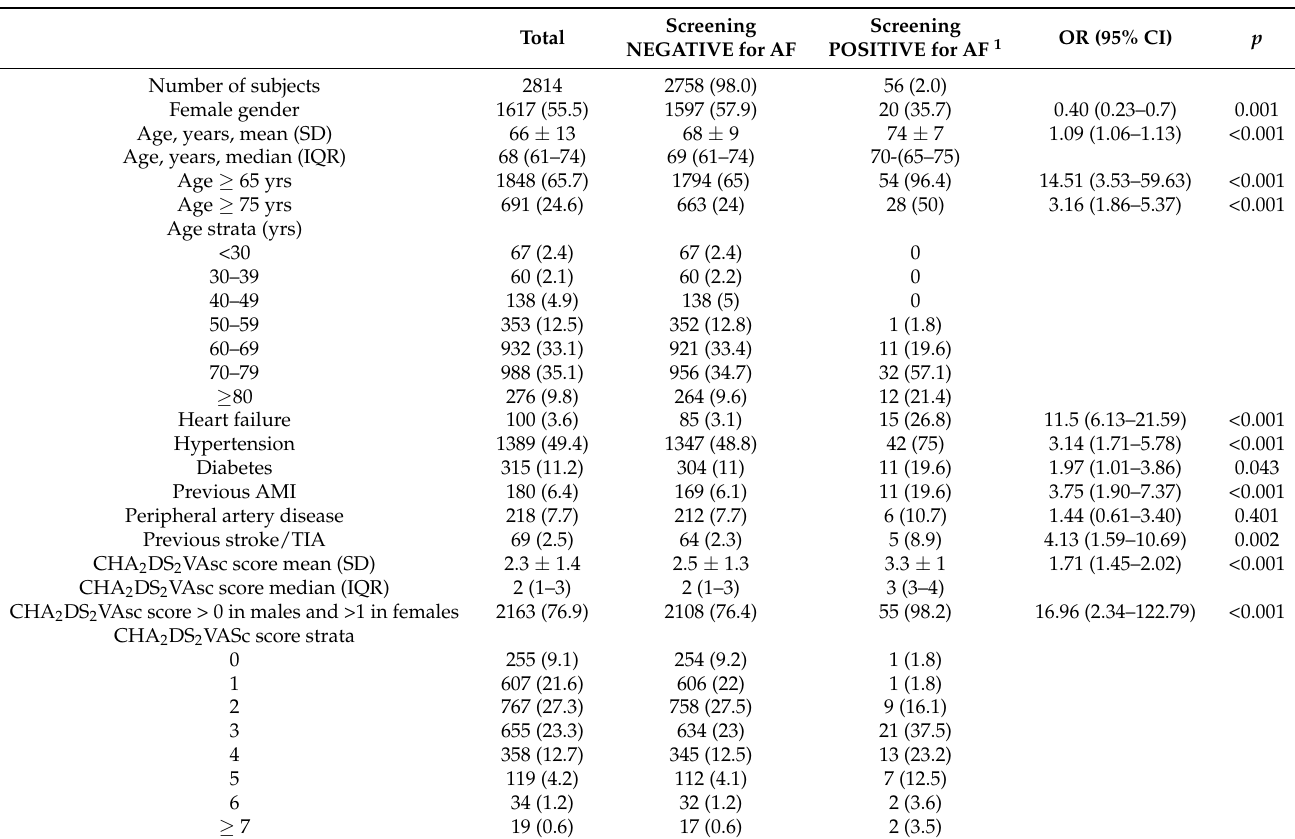
Table 1. Baseline characteristics of the whole population, and subjects with a negative and a positive screening for atrial fibrillation (AF), respectively. Data are shown as number (%). The results of univariate comparisons are also shown.